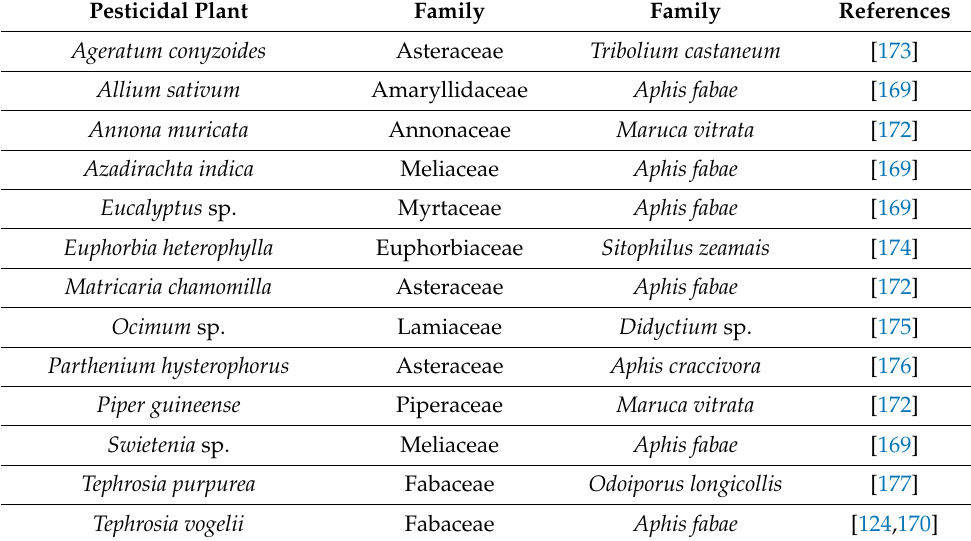
Table 6. Pesticidal plants common to SSA used for different pest